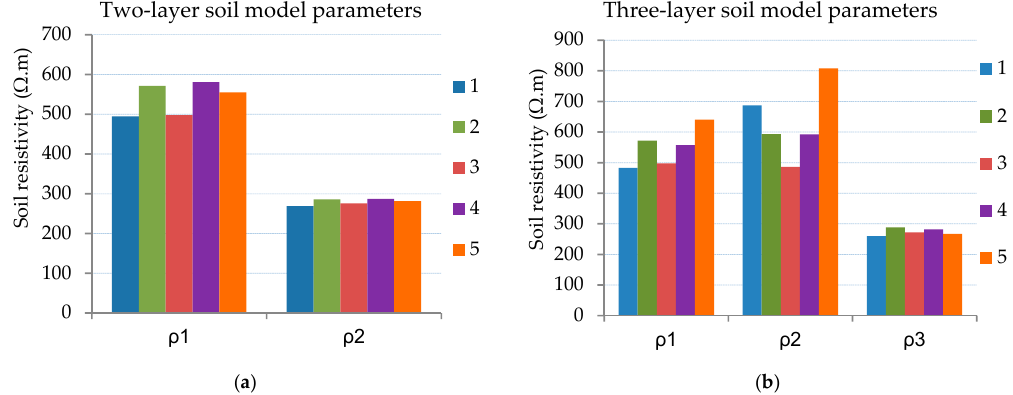
Figure 3. ( a ) Variation of the two-layer soil model parameters with respect to the resistivity measuring axes (see Table 2); ( b ) variation of the three-layer soil model parameters with respect to the resistivity measuring axes (see Table 3).